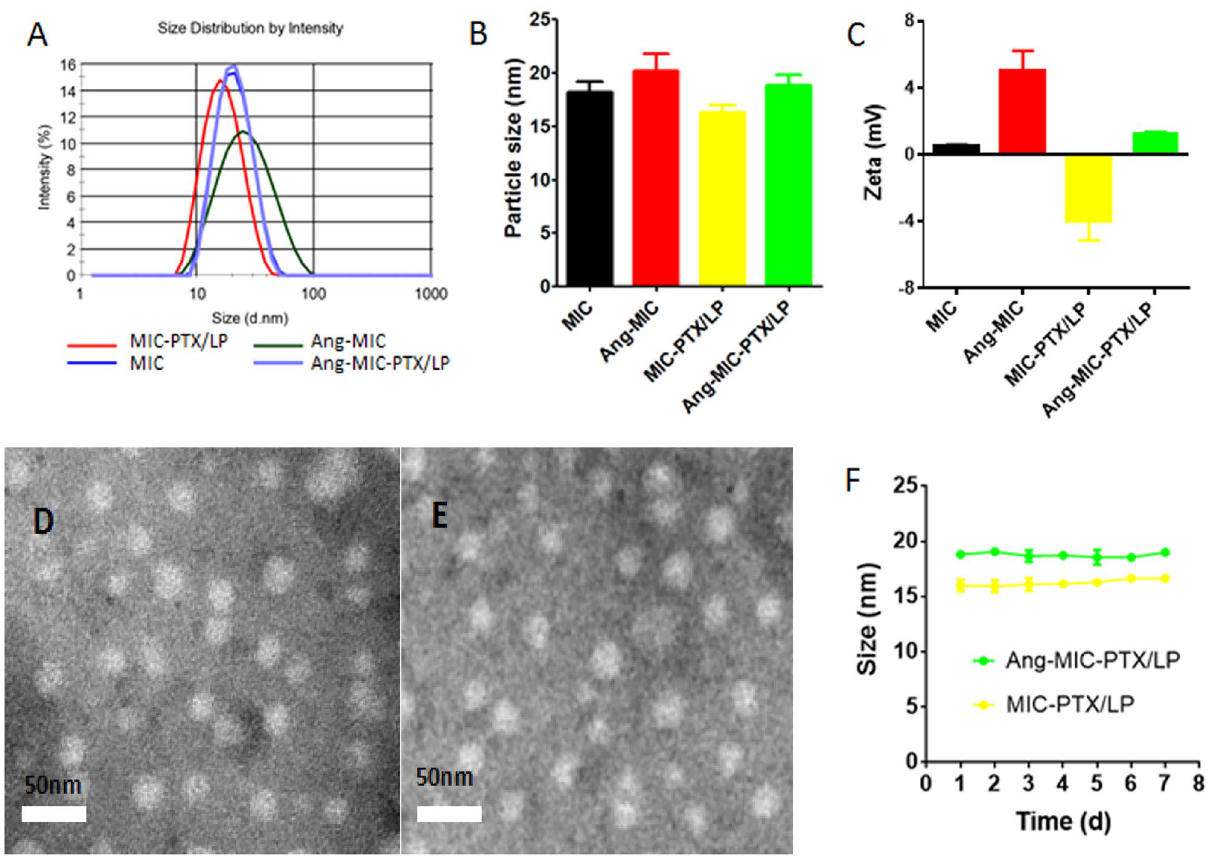
Figure 1. Characterization of Ang-MIC-PTX/LP. ( A ) Size distribution, ( B ) average size and ( C ) zeta potential of different micelles. TEM images of ( D ) MIC-PTX/LP and ( E ) Ang-MIC-PTX/LP. ( F ) Stability of MIC-PTX/LP and Ang-MIC-PTX/LP stored at 4 °C for 7 days (n =